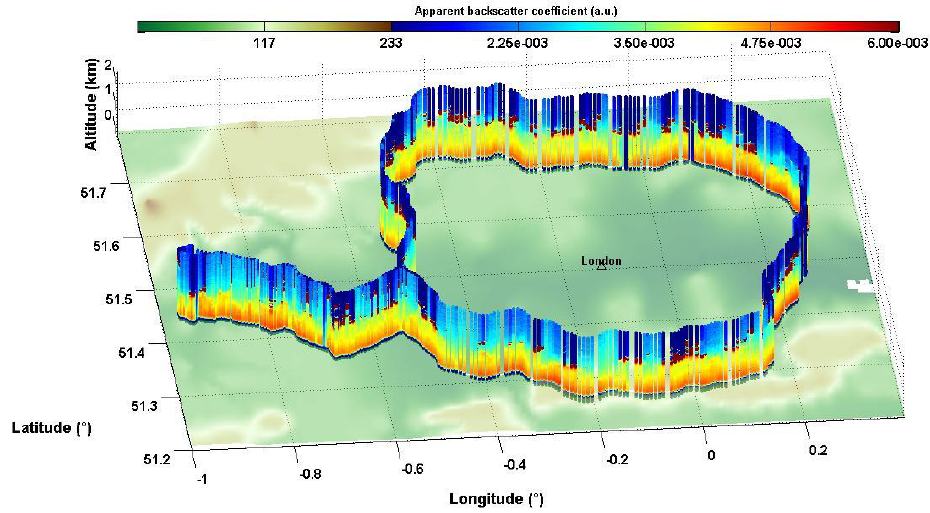
Figure 12. Apparent lidar backscatter coefficient at 355 nm measured around the M25 motorway 1184 Fig. 13. Apparent lidar backscatter coefficient at 355nm measured around the M25 motorway on the 16